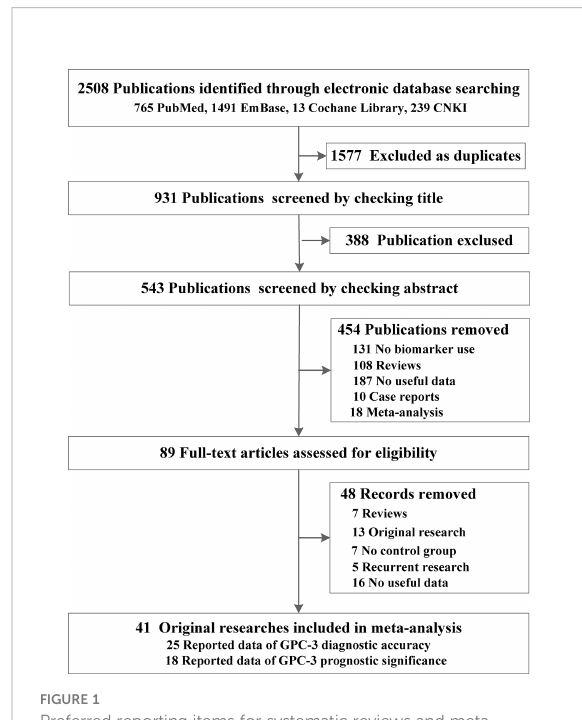
FIGURE 1 Preferred reporting items for systematic reviews and meta- analyses fl owchart of the identi fi cation of eligible research